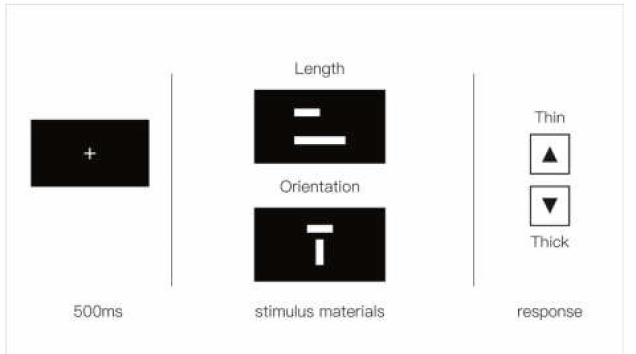
Figure 3. Schematic outline of the order of tasks in the experiment. During each trial, after a blank display (500 ms), stimulus materials were shown on the screen, and subjects were instructed to adjust the thickness of a stimulus line to a target